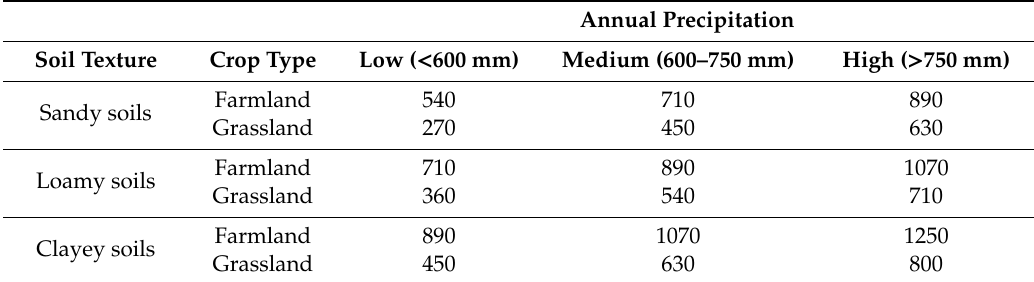
Table 6. Calcium losses due to neutralization and leaching in kg CaCO 3 ha − 1 (after [58]; modified). Annual